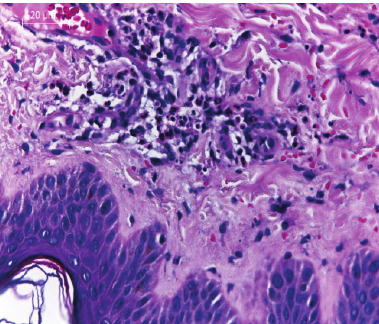
Figure 2: The walls of the small blood vessels are infiltrated by mixed inflammatory cells; skin biopsy showing leukocytoclastic